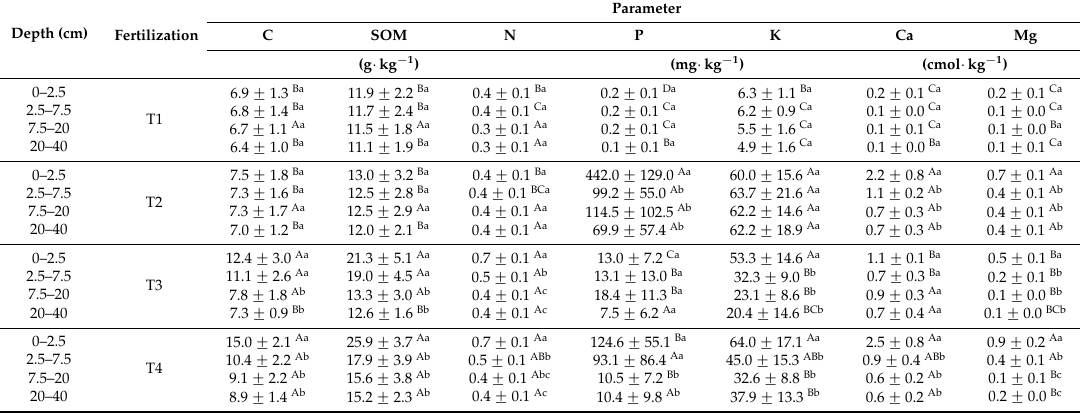
Table 2. Concentrations of macronutrients (C, N, P, K, Ca and Mg) and soil organic matter (SOM) in the soil of a forest plantation with leguminous trees in a degraded area near the Balbina hydroelectric dam, Amazonas State, Brazil, after the application of the fertilization treatments.